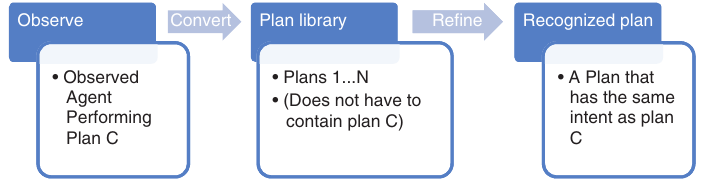
Figure 3. Intent Recognition Process.